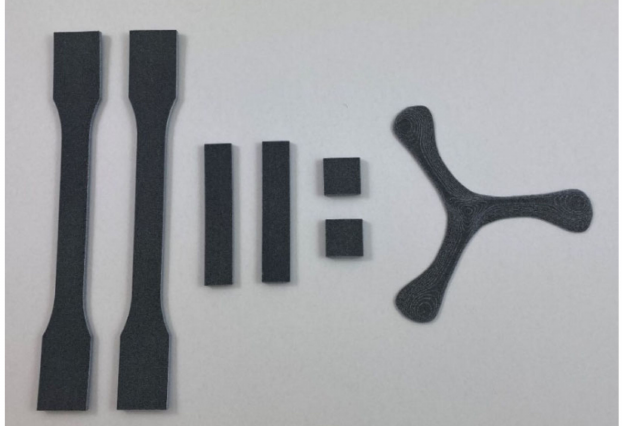
Figure 8. Overview of the different types of parts manufactured from PET by HSS (from left: tensile bars, microscopy cuboids, density cubes and propeller). The propeller showed a pattern of white streaks caused by the energy input of the sintering lamp in combination with a low bed temperature.